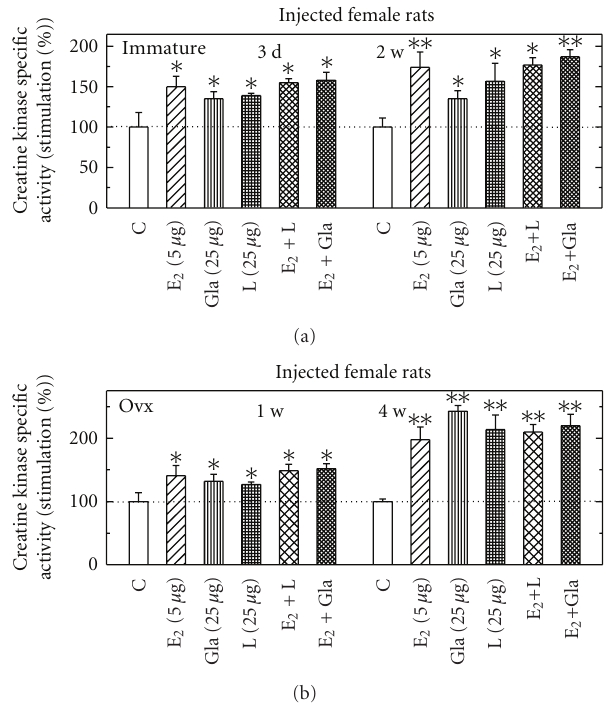
Figure 6: Stimulation of creatine kinase (CK) specific activity by licorice (L), glabridin (Gla) with and without E 2 in pituitary from immature (a) or from Ovx female rats (b). Rats were fed for di ff erent time periods as indicated and assayed for CK activity as described in Section 2. Results are means ± SEM for n = 5–10 rats/group. Experimental means compared to control means: ∗ P < . 05 and ∗∗ P < . 01. Basal activity in Pi from immature rats was 0 . 97 + 0 . 22 μ mol/min/mg protein and from Ovx rats was 0 . 67 + 0 . 18 μ mol/min/mg